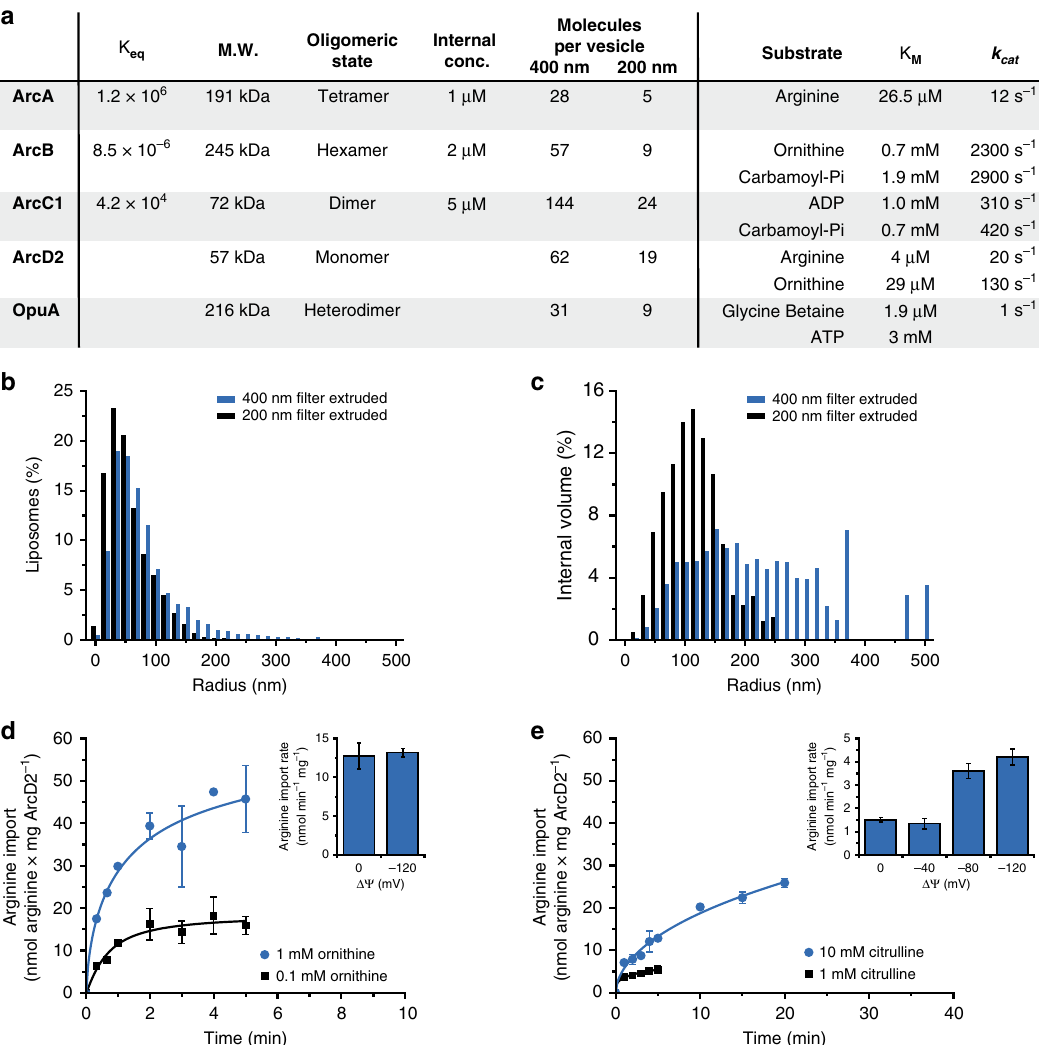
Fig. 2 Characterization of the components of the system. a Molecular and kinetic properties of the enzymes; K eq was calculated as in Fig. 1c. The K M values of a given substrate were determined under conditions of excess of the other substrate. The number of molecules per vesicle was calculated from the internal concentration of the enzymes and the average size of the vesicles, for 400 nm (left column) and 200 nm (right column) extruded vesicles. Kinetic parameters of ArcB are given for the back reaction. The kinetic parameters of ArcD2 were estimated from measurements in cells 48 , assuming that ArcD2 constitutes 1% of membrane protein; the data for OpuA are from ref. 40 . b Distribution of the radius of lipid vesicles extruded through a 400 nm (blue bars) and 200 nm (black bars) polycarbonate fi lter as estimated from CryoTEM micrographs (Supplementary Fig. 1). The diameter of 2090 vesicles (400 nm fi lter) and 2092 vesicles (200 nm fi lter) were measured using ImageJ. c Distribution of the internal volume, based on the distribution of radii, assuming that all vesicles are spherical. d Kinetics of arginine uptake in proteoliposomes with 1 mM (blue circles) and 0.1 mM (black squares) ornithine on the inside (protocol B2); 14 C-arginine concentration of 10 µ M. Inset: in fl uence of a membrane potential ( ΔΨ ) on arginine uptake with 1 mM ornithine on the inside. Data from replicate experiments ( n = 2) are shown, error bars indicate standard deviation. e Kinetics of arginine uptake in proteoliposomes with 10 mM (blue circles) and 1 mM (black squares) citrulline on the inside (protocol B2); 14 C-arginine concentration of 10 µ M. Inset: in fl uence of a membrane potential ( ΔΨ ) on arginine uptake with 10 mM citrulline on the inside ( n = 2). Source data of are provided as a Source Data fi le